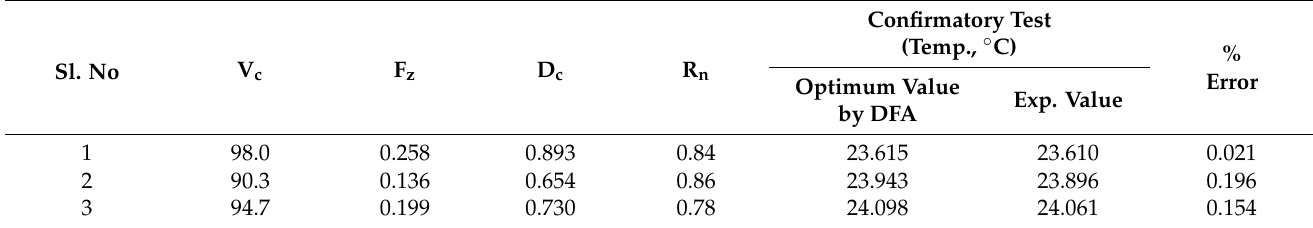
Table 6. Optimized process parameter—validation